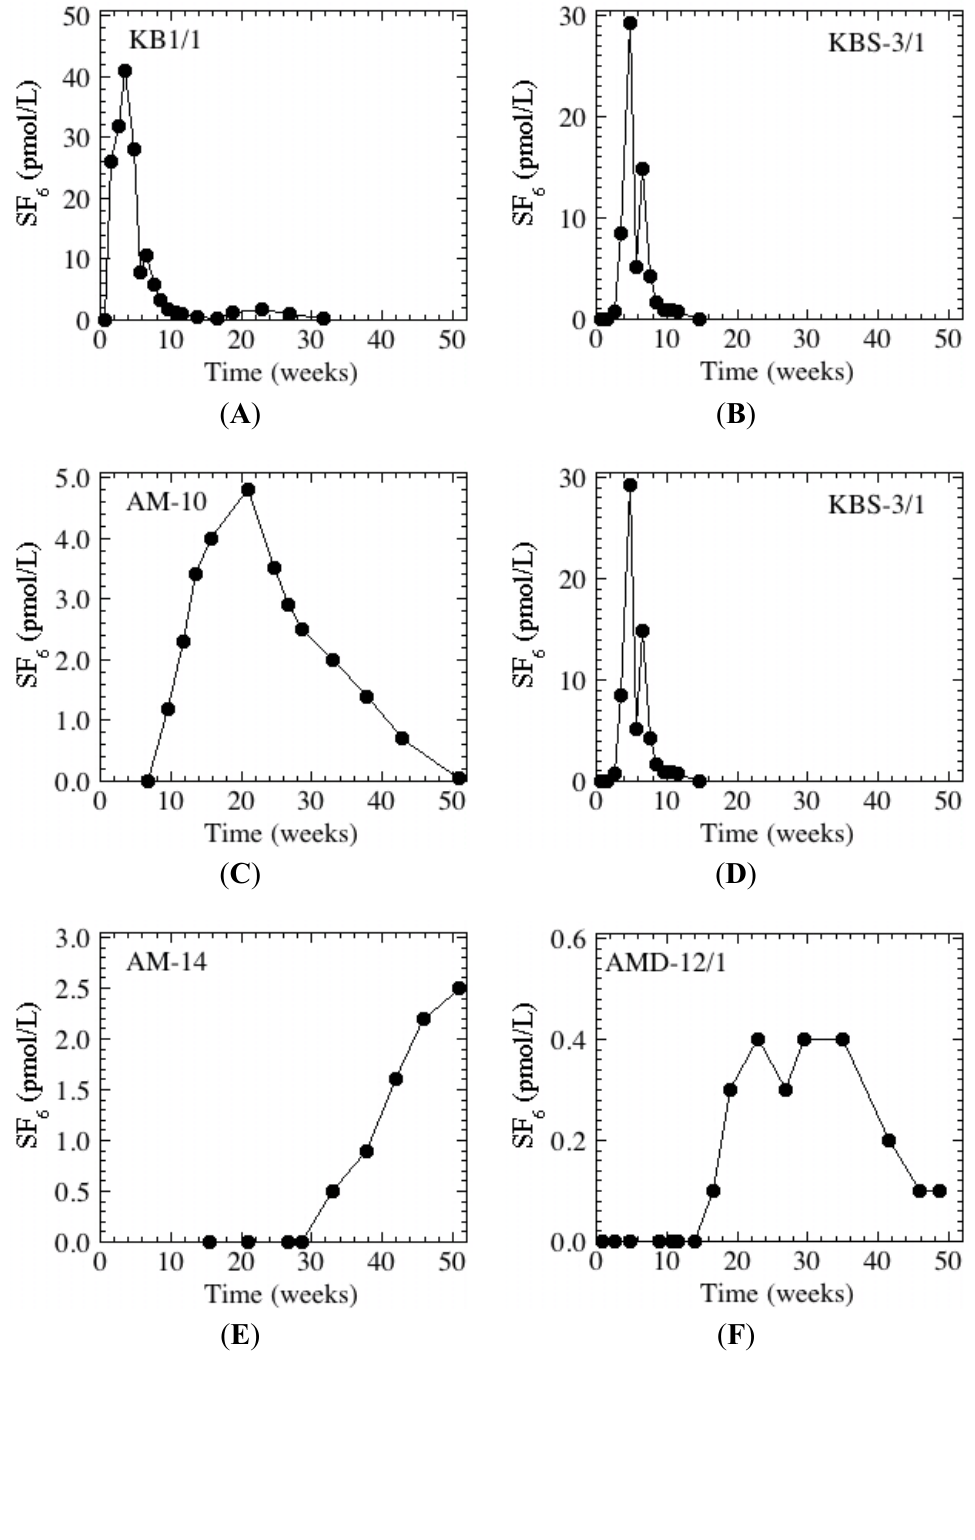
Figure 4. Breakthrough curves at representative wells. Wells found along, respectively, the southern ( A , C , E ) and northern ( B , D , F ) flow paths are displayed on the left and right. The mean pond concentration was 66 pmol/L and non-detections (<0.05 pmol/L) have been plotted as “0 pmol/L”. Please note that the scale on the y-axes (concentration)